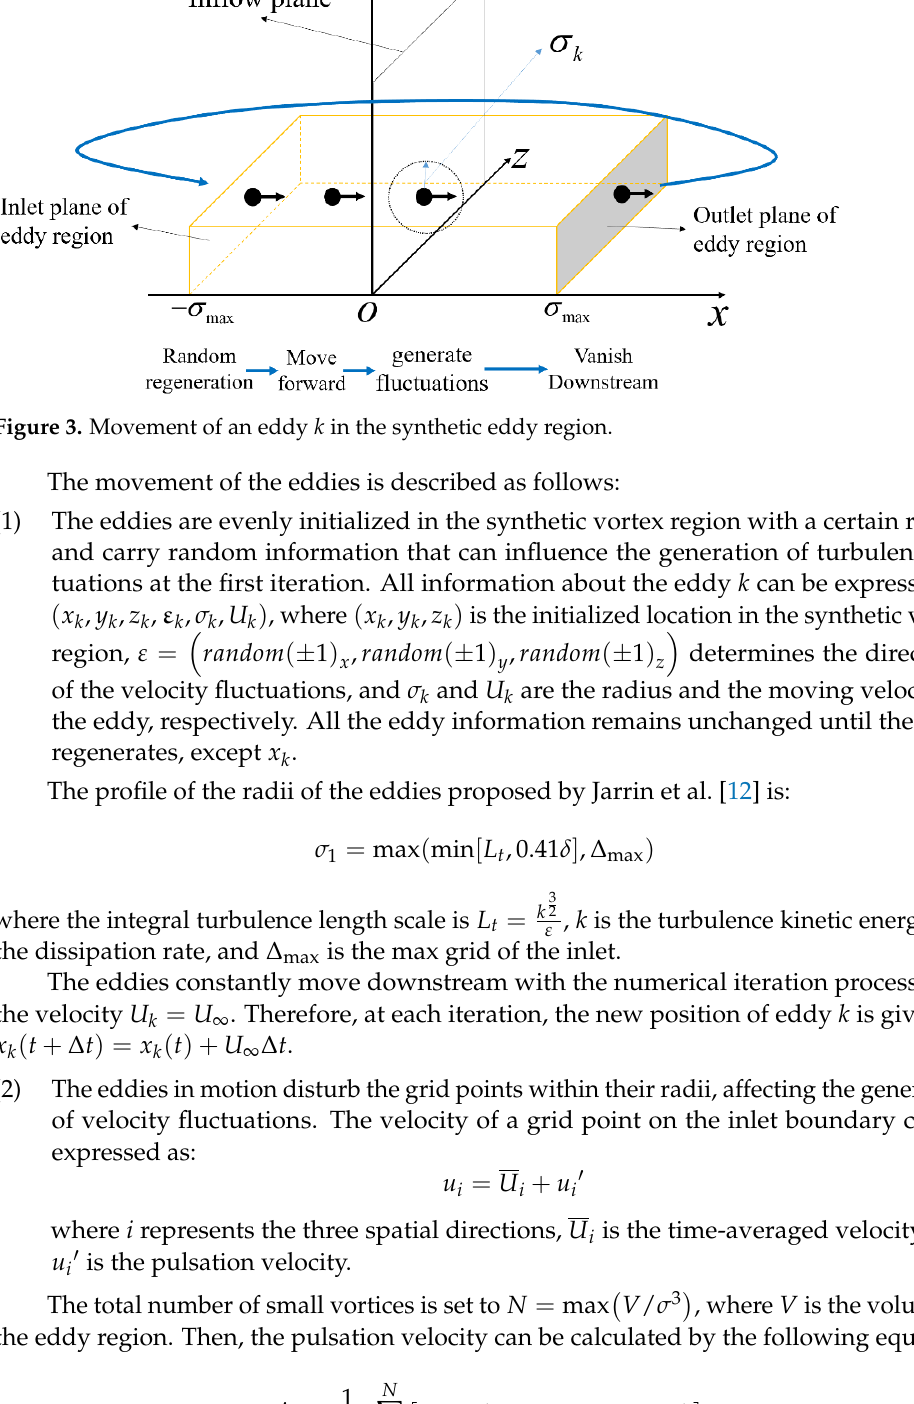
Figure 3. Movement of an eddy k in the synthetic eddy region.